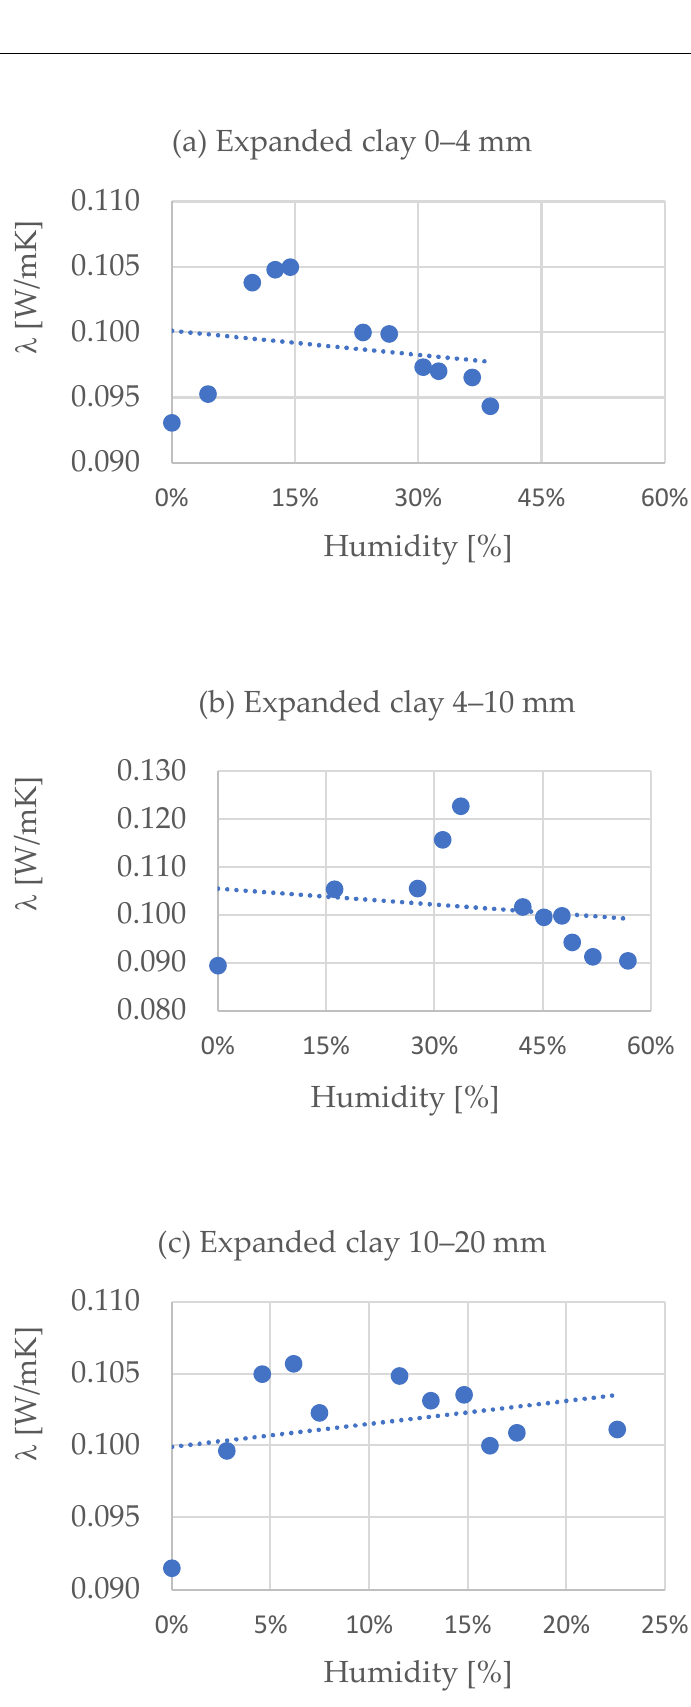
Figure 3. Measurement results of the thermal conductivity for expanded clay, ( a ) expanded clay 0–4 mm, ( b ) expanded clay 4–10 mm, ( c ) expanded clay 10–20 mm.